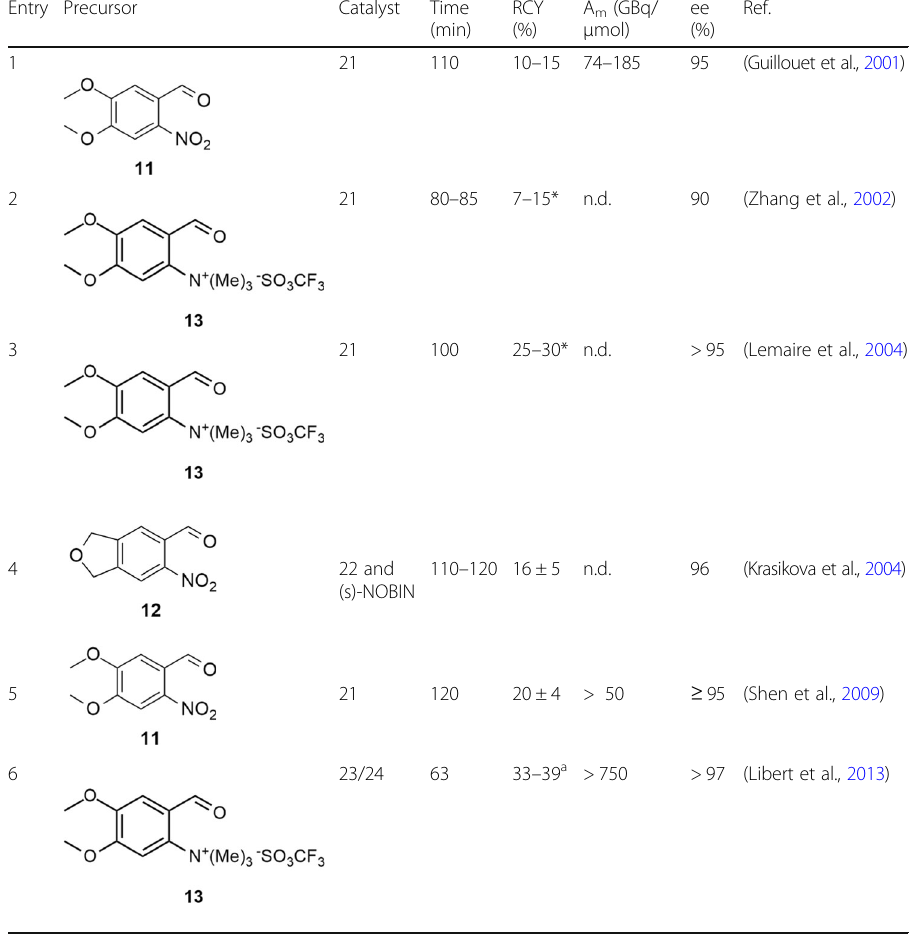
Table 2 Synthesis of 6-[ 18 F]FDOPA starting from different precursors using different